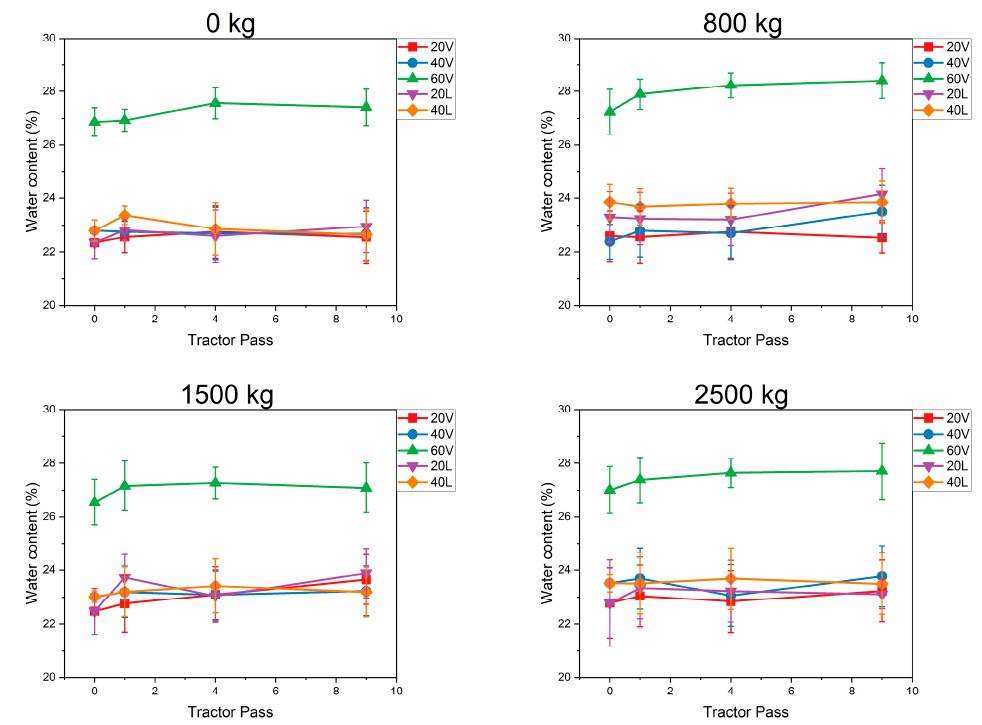
Figure 11. Soil moisture content in different traction conditions.